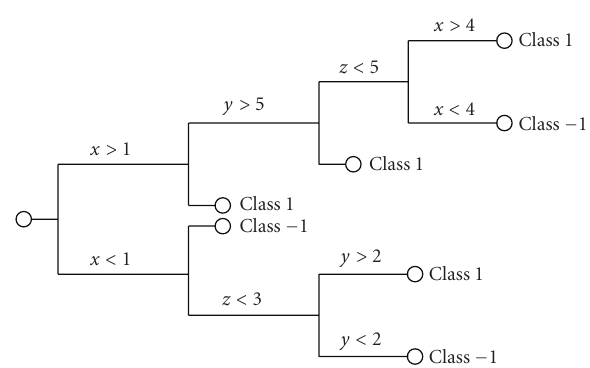
Figure 3: A sketch of a classification tree, wherein the leaves represent classes and the branches represent conjunctions of features that lead to those